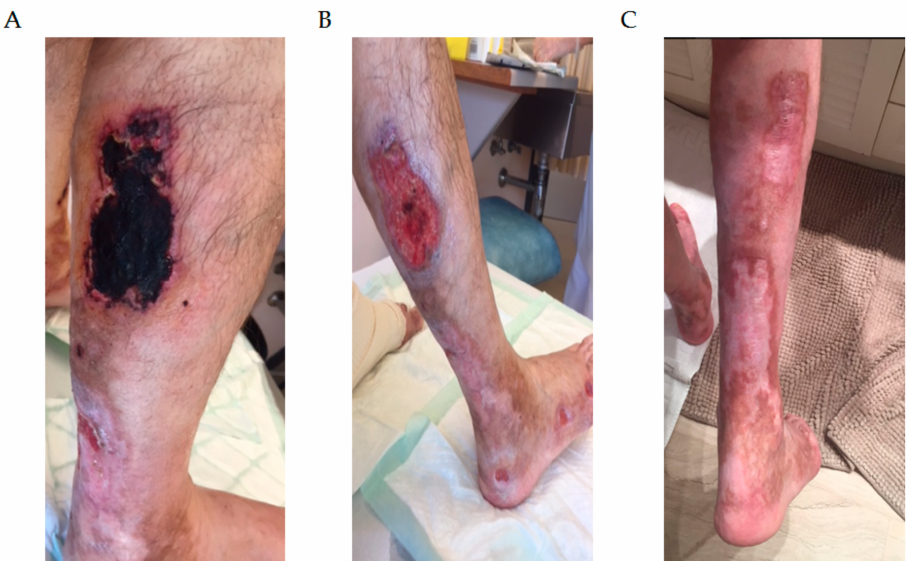
Figure 1. Patient diagnosed with multiple myeloma and type 1 cryoglobulinemia, causing severe skin ulceration on lower extremities. ( A ) Skin ulcers before daratumumab. ( B ) Improvement of the skin condition during treatment. ( C ) Complete resolution of the skin ulcers with